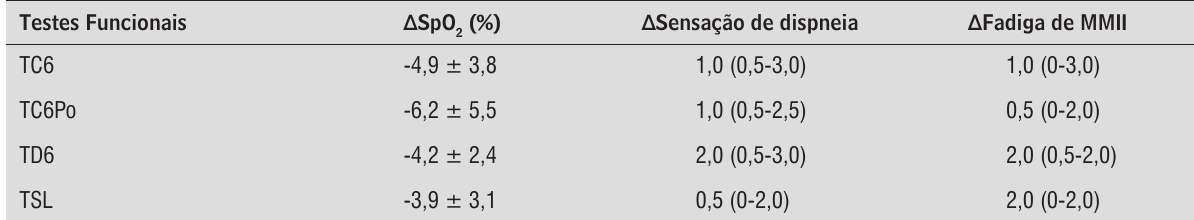
Tabela 2 - Valores dos deltas de variação da saturação periférica de oxigênio, sensação de dispneia, fadiga de